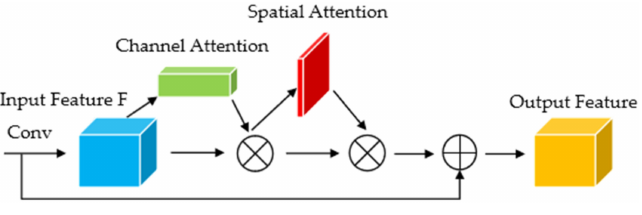
Figure 10. The architecture of the CBAM module.